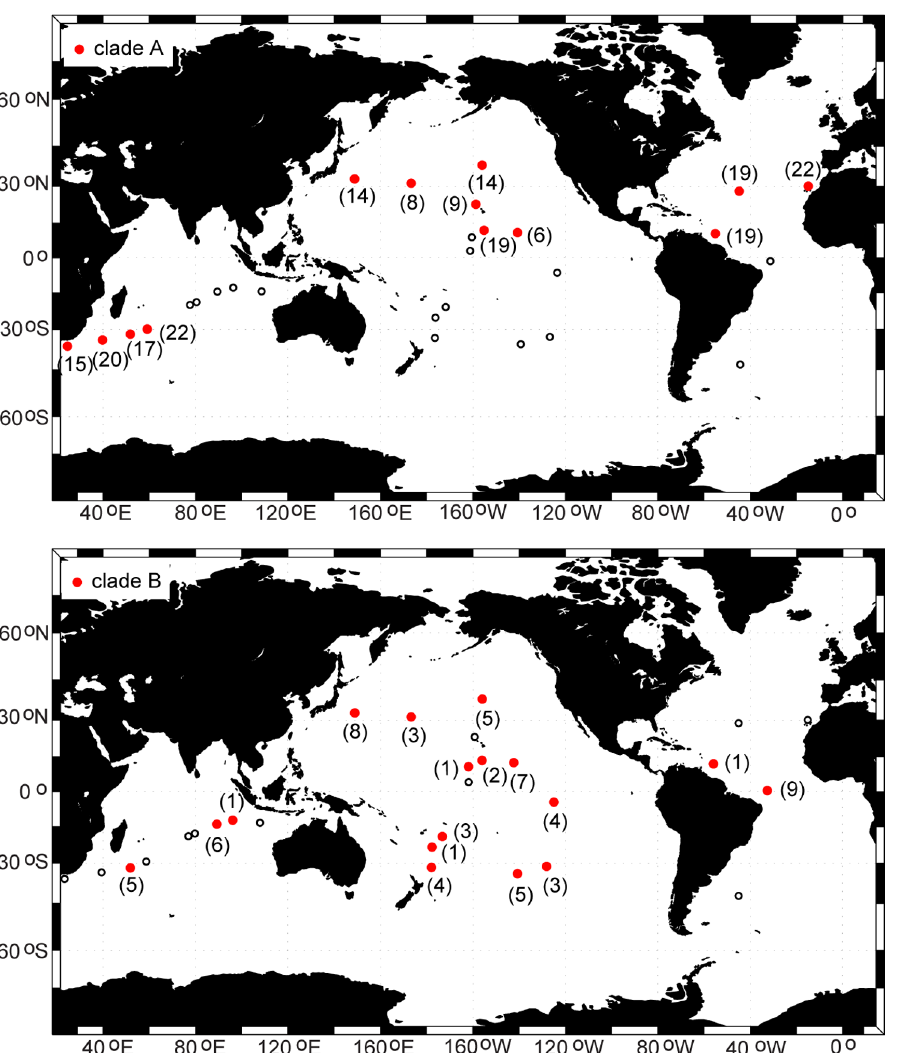
Figure 7. Distribution map for cosmopolitan clades A (top panel) and B (bottom panel). The number of specimens (n) for each site is given in parentheses beside the symbol. Small, open circles indicate sample locations that did not include any specimens of this clade (absence).